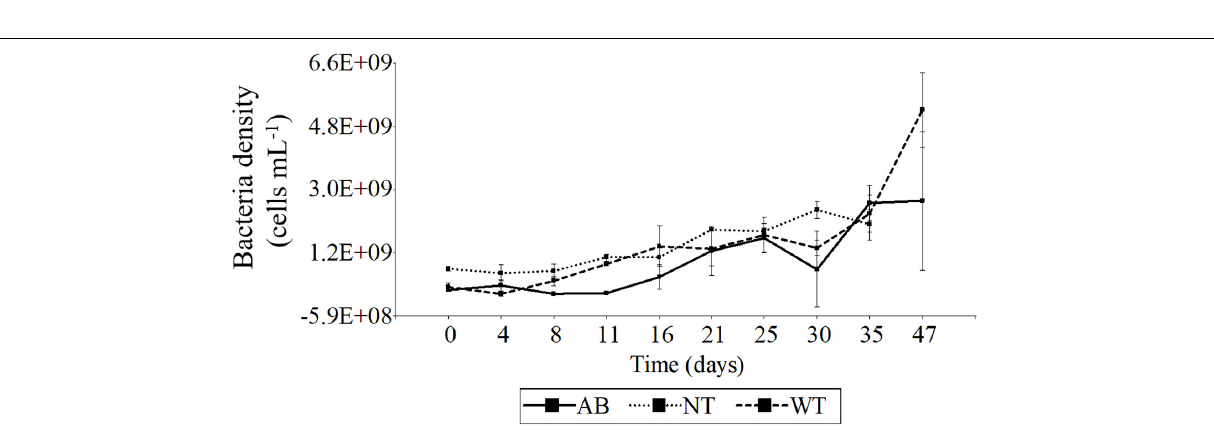
FIGURE 7 | Time-series of bacterial cell density from Prorocentrum PA1 cultures under various treatments. AB, washed cells plus antibiotics; WT, washed cells; NT, non-treated culture (control). AB, WT, and NT: n = 3 from Day 0 to 35, AB and WT: n = 2 on Day 47. Error bars indicate mean ± standard deviation (SD) of replicate cell